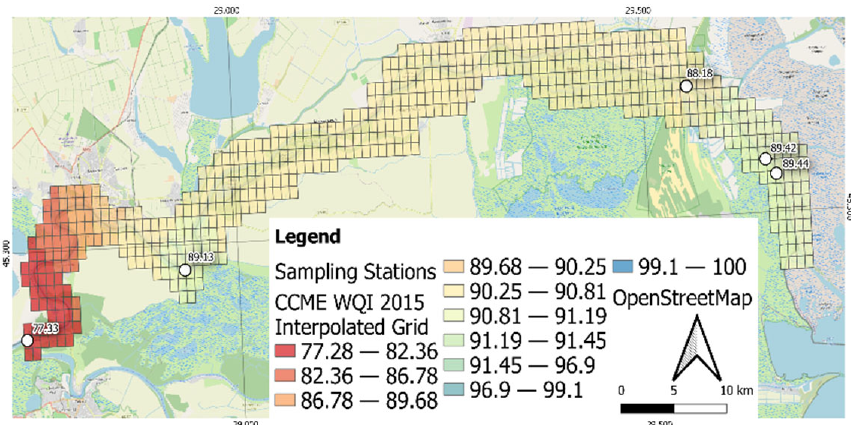
Figure 6. CCME WQI trends in 2015 on the Chilia branch.